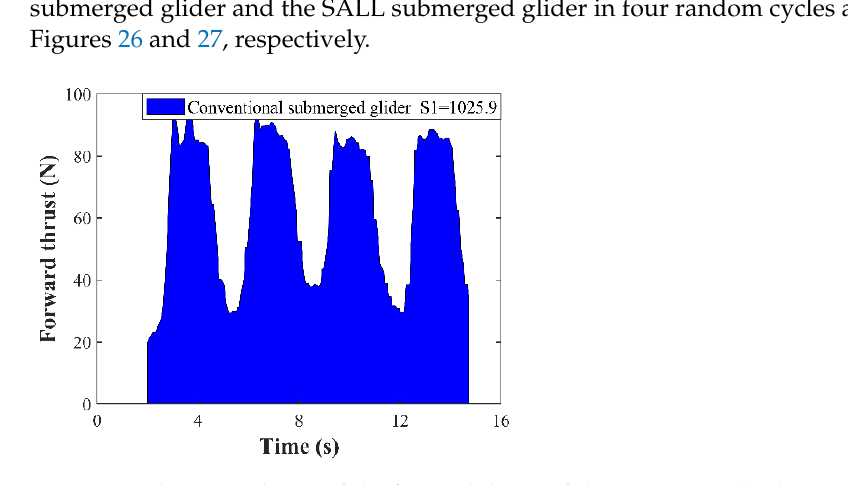
Figure 26. The integral area of the forward thrust of the conventional submerged glider in four random cycles.